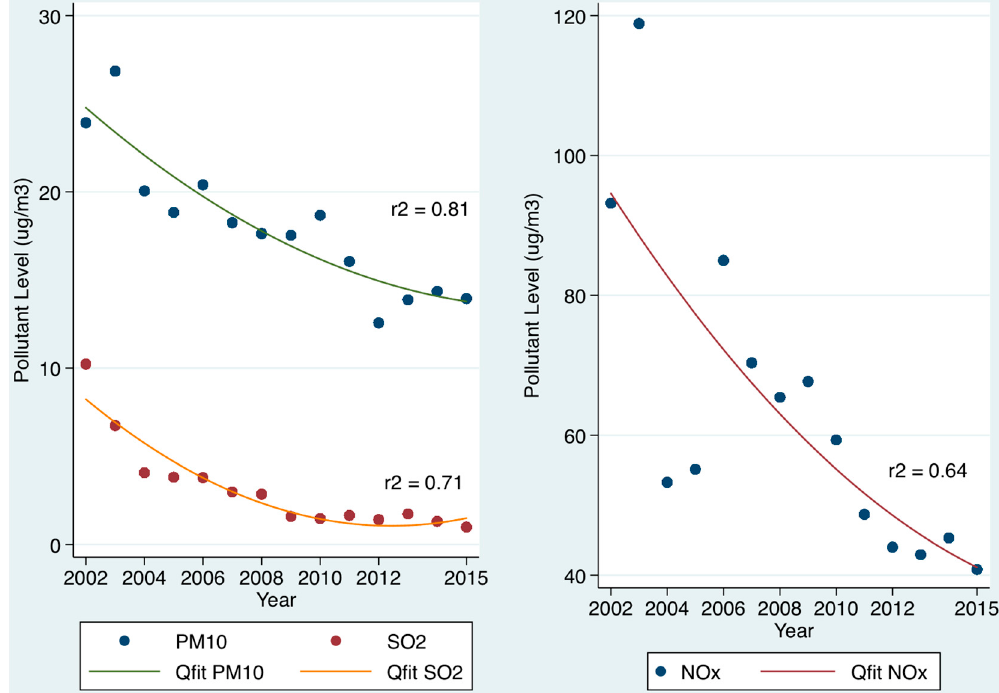
Figure 1. Annual trends of air pollution (PM 10 , NO x , and SO 2 ) over time from 2002 to 2015. For all three pollutants, there annual average levels have declined over time. The trend lines are nonlinear quadratic fits. Table 1. Logistic multivariable model of 30-day in hospital mortality related to admission levels of PM 10 and SO 2 , with adjustment for other risk predictors.